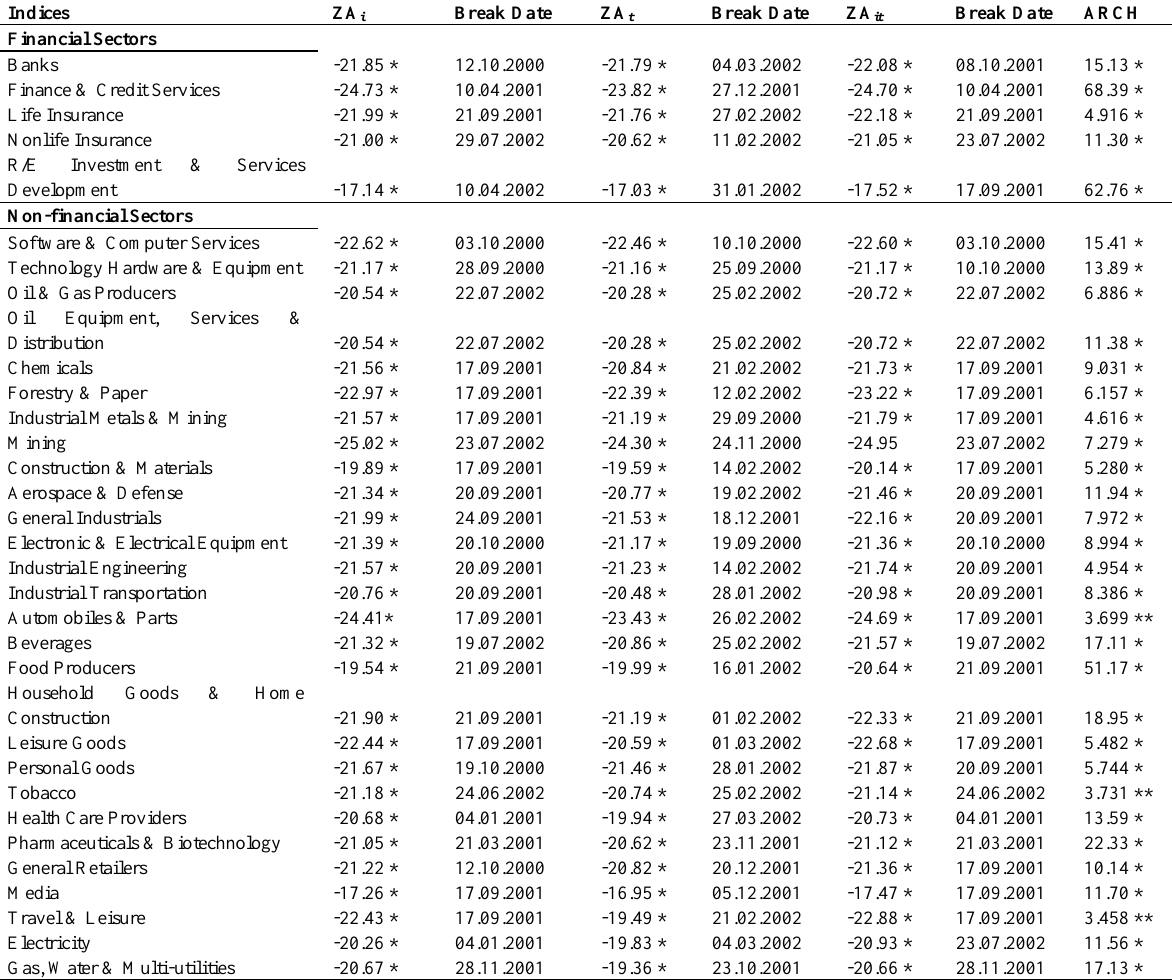
Table 2: Zivot and Andrews (1992) unit root test and ARCH effect on the indices returns at